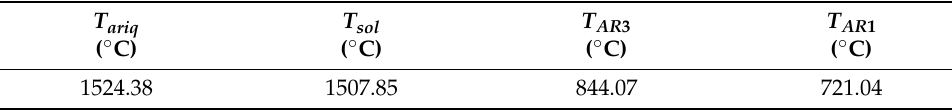
Table 2. Temperatures of the steel.